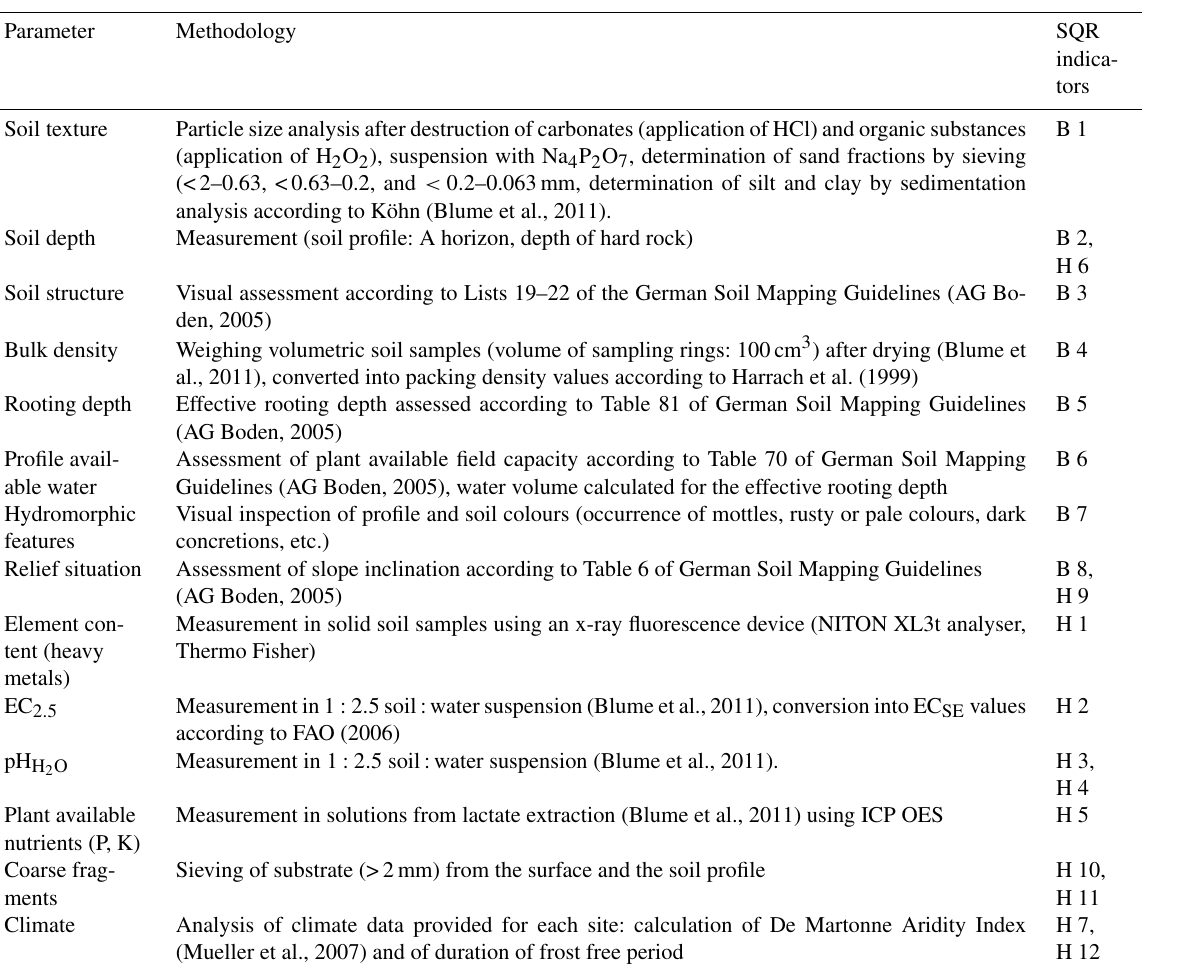
Table 2. Soil parameters assessed in the field and as basis for assessing SQR indicators. Parameter Methodology